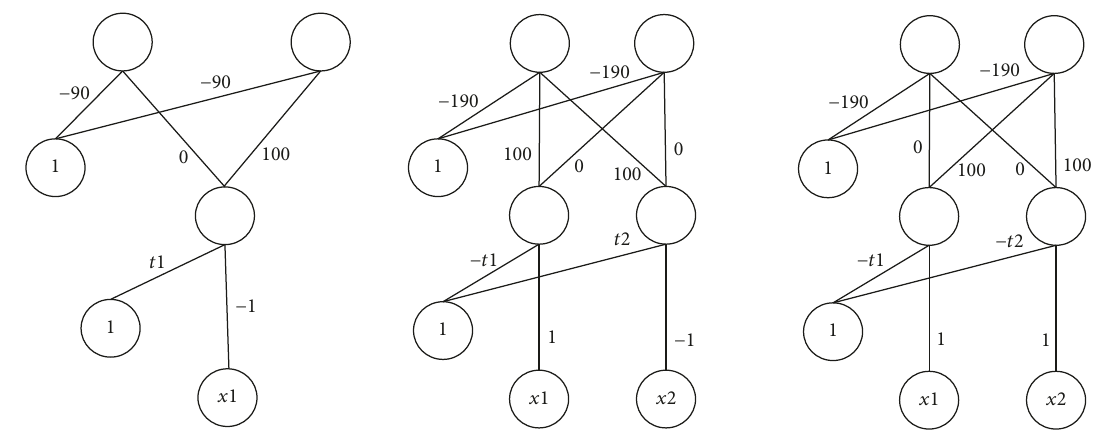
Figure 5: Three symbolic rules represented by three DIMLP networks with a step activation function in the hidden layer and a sigmoid function in the output layer (see the rules in the text). Weight values 𝑡 1 and 𝑡 2 are constants denoting thresholds of rule